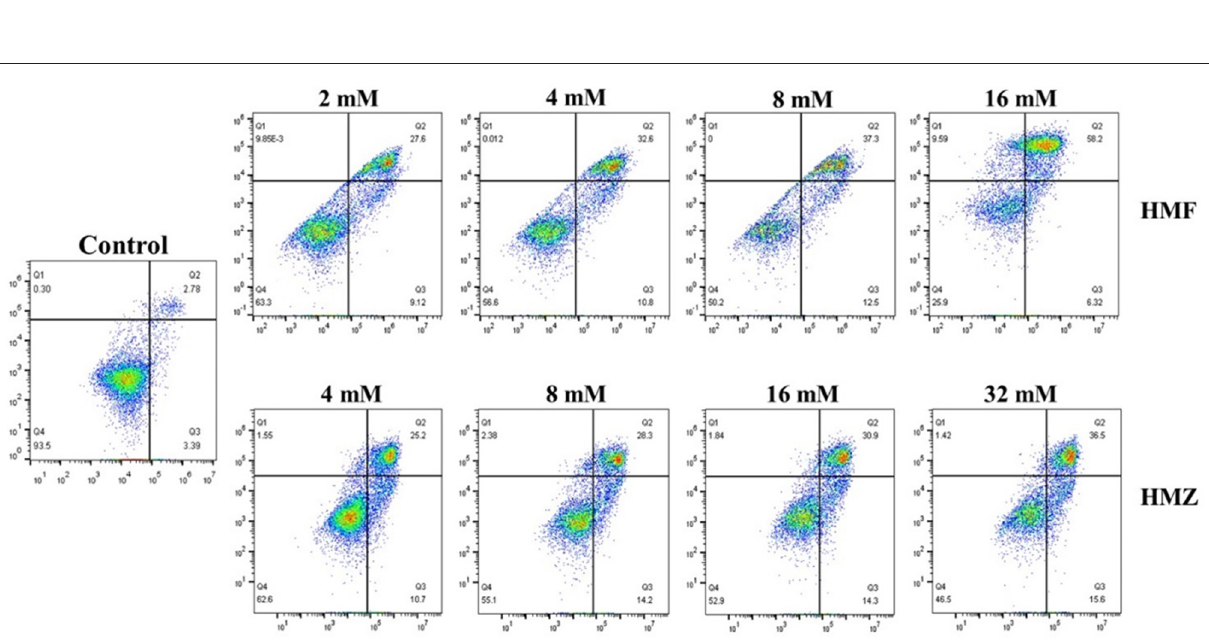
FIGURE 4 | Effects of HMF and HMZ at different concentrations on cell viability after 24 and 48h. Different letters indicated significant differences ( P < 0.05).